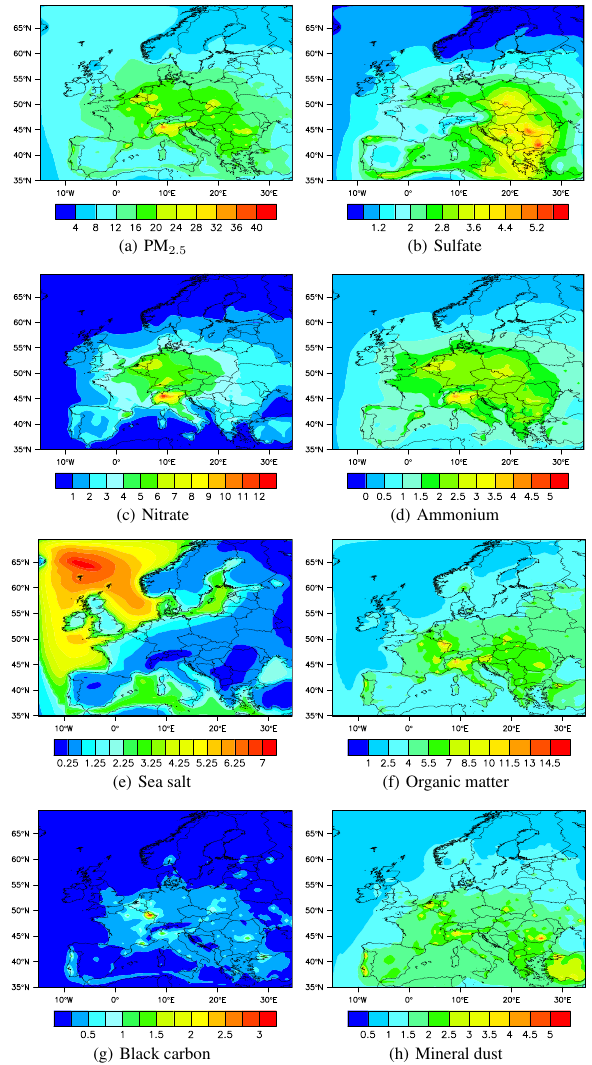
Fig. 2. Nine-year (2000–2008) averaged surface concentrations of PM 2 . 5 and its components, expressed in µgm − 3